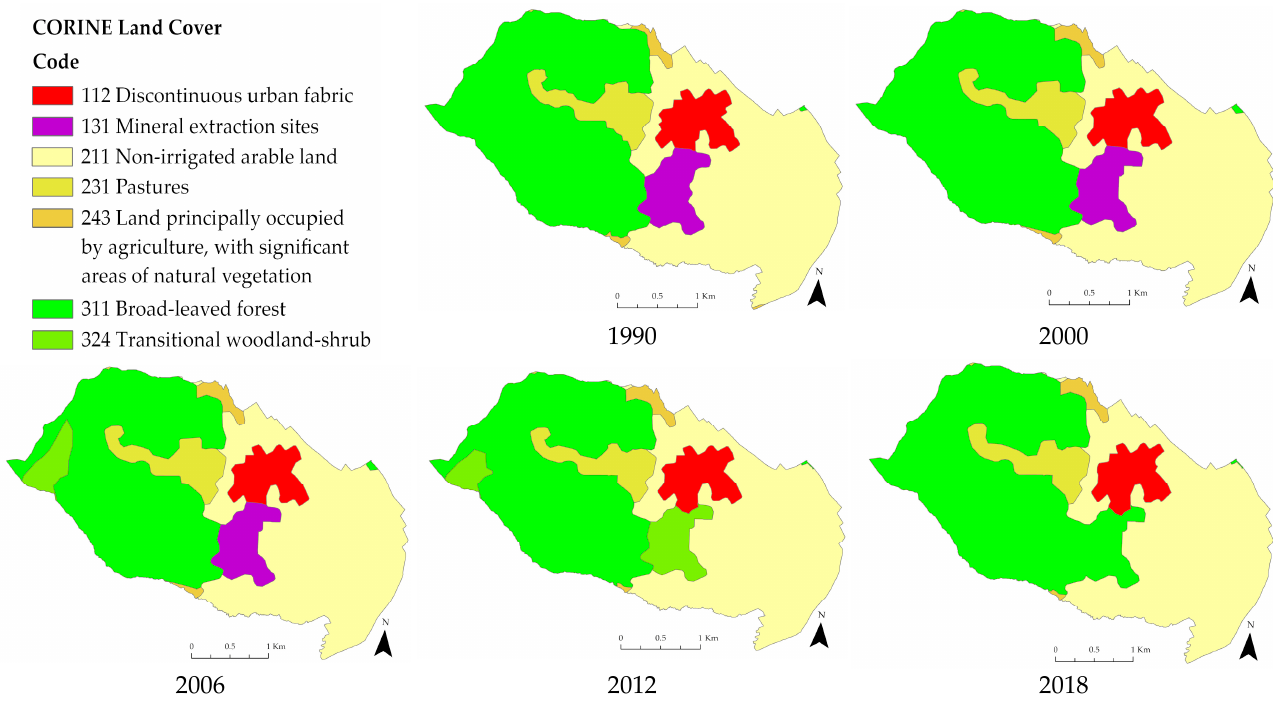
Figure 6. Corine Land Cover for the selected time period.